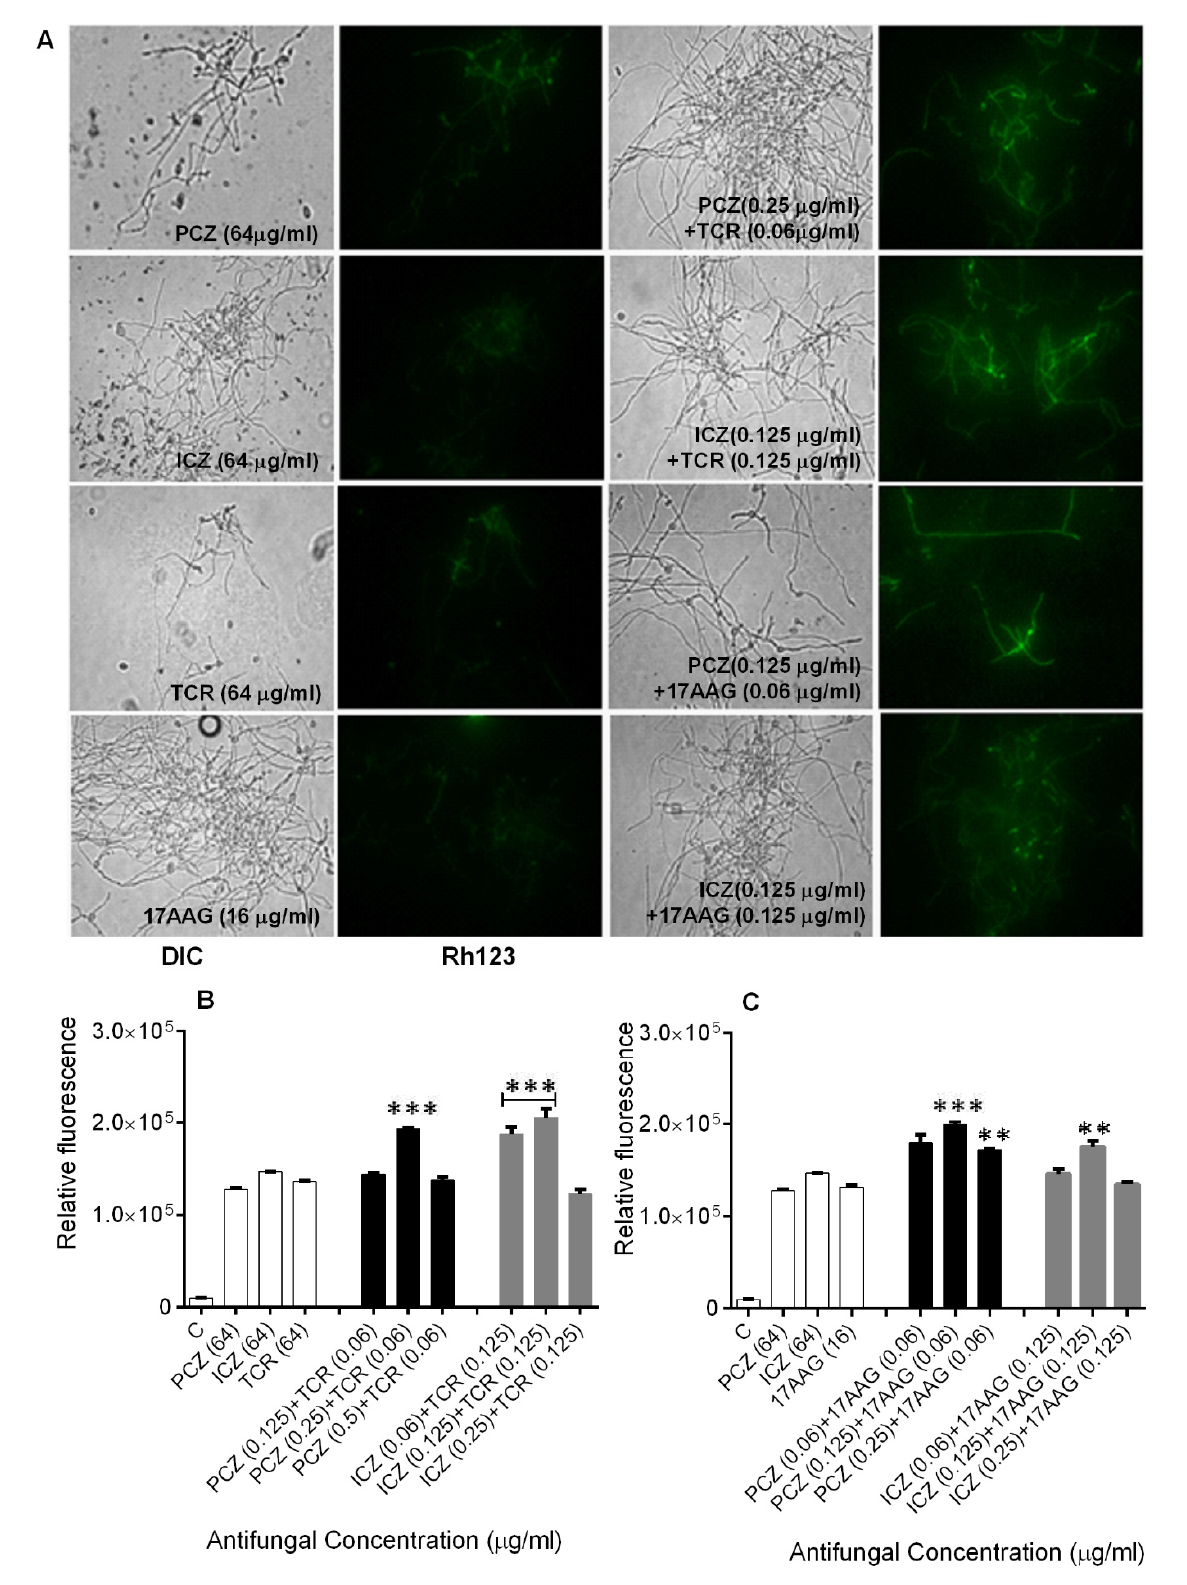
FIGURE 3: Changes in DDD DY YY Y m in S. prolificans isolate 1 germlings triggered by treatment with PCZ or ICZ combined with TCR or 17AAG. (A) Fluorescence images of S. prolificans germlings stained with Rh-123. (B, C) Relative fluorescence levels in S. prolificans germlings treated with PCZ or ICZ plus TCR (B) and PCZ or ICZ plus 17AAG (C) . **p<0.001; ***p<0.0001. Error bars on graphs indicate standard deviation. DIC, differential interference OPEN ACCESS | www.microbialcell.com 184 Microbial Cell | June 2014 | Vol. 1 No. 6